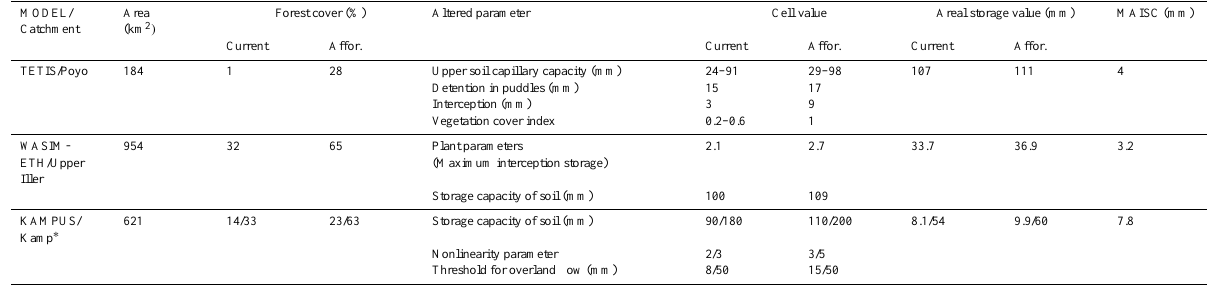
Table 5. Parameters altered by the afforestation